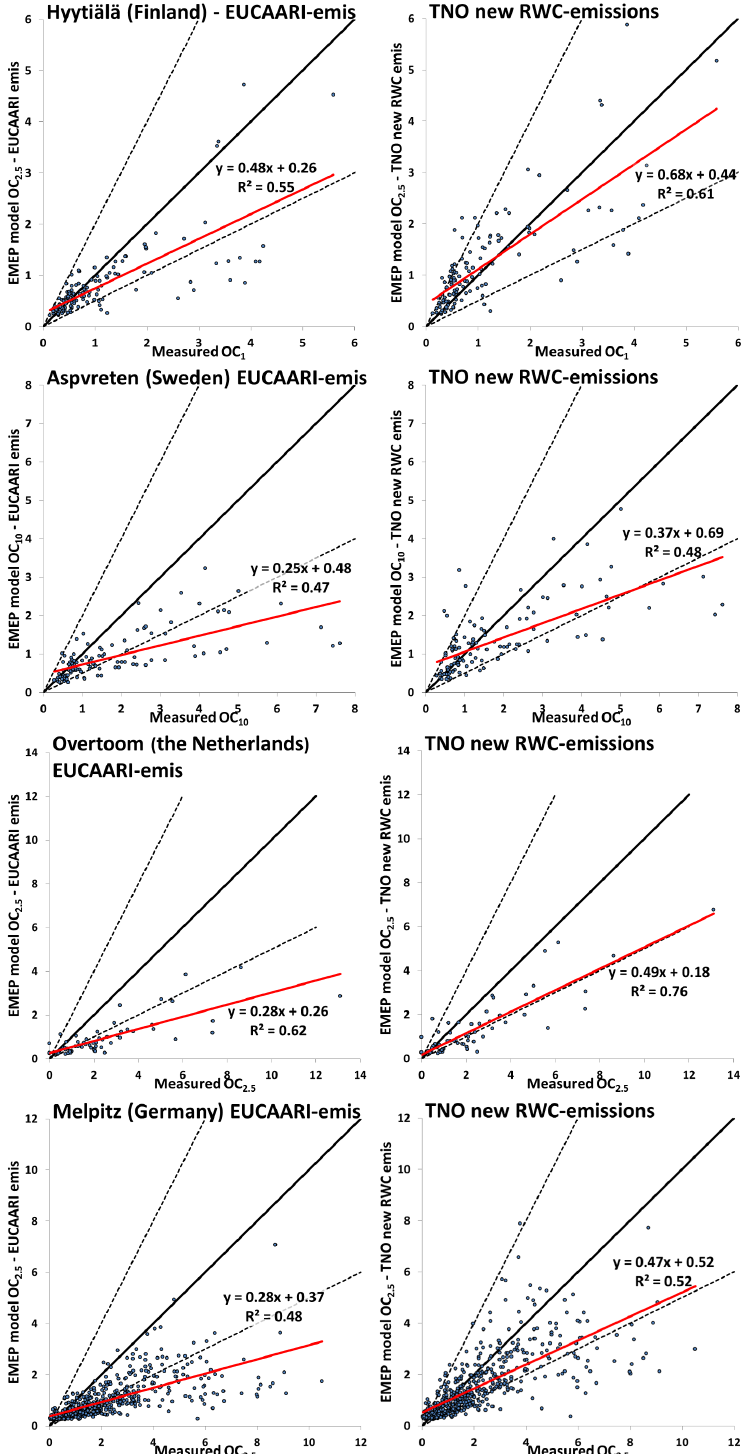
Figure 7. Measured and modelled organic carbon concentrations (2007–2009, winter half-year data: November–April) at four sites: Hyytiälä (FI), Aspvreten (SE), Overtoom (NL) and Melpitz (DE). The left-hand side plots show EMEP MSC-W model results using the EUCAARI emissions and the right-hand side plots results using the revised residential wood combustion emissions. For Hyytiälä measurements are OC in PM 1 and model results are OC in PM 2 . 5 ; for Aspvreten OC in PM 10 is shown; for Overtoom and Melpitz, OC in PM 2 . 5 . Each point represents one measurement (variable sampling duration, from 17h to 2 weeks). Unit: µg ( C ) m − 3